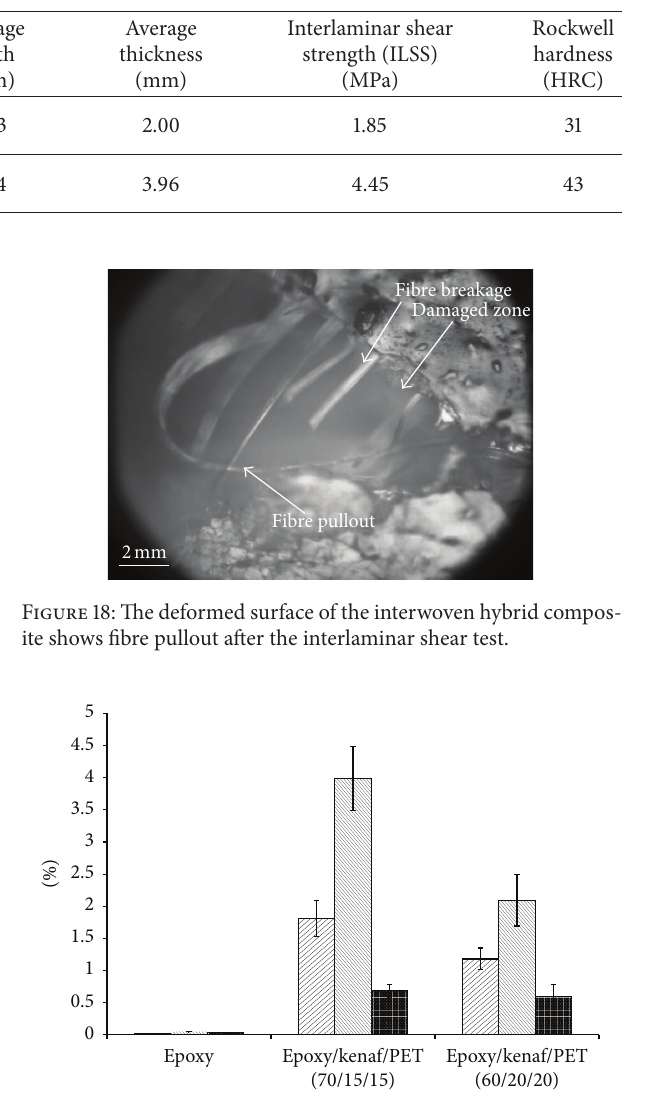
Table 1: Results of interlaminar shear strength and Rockwell hardness number.